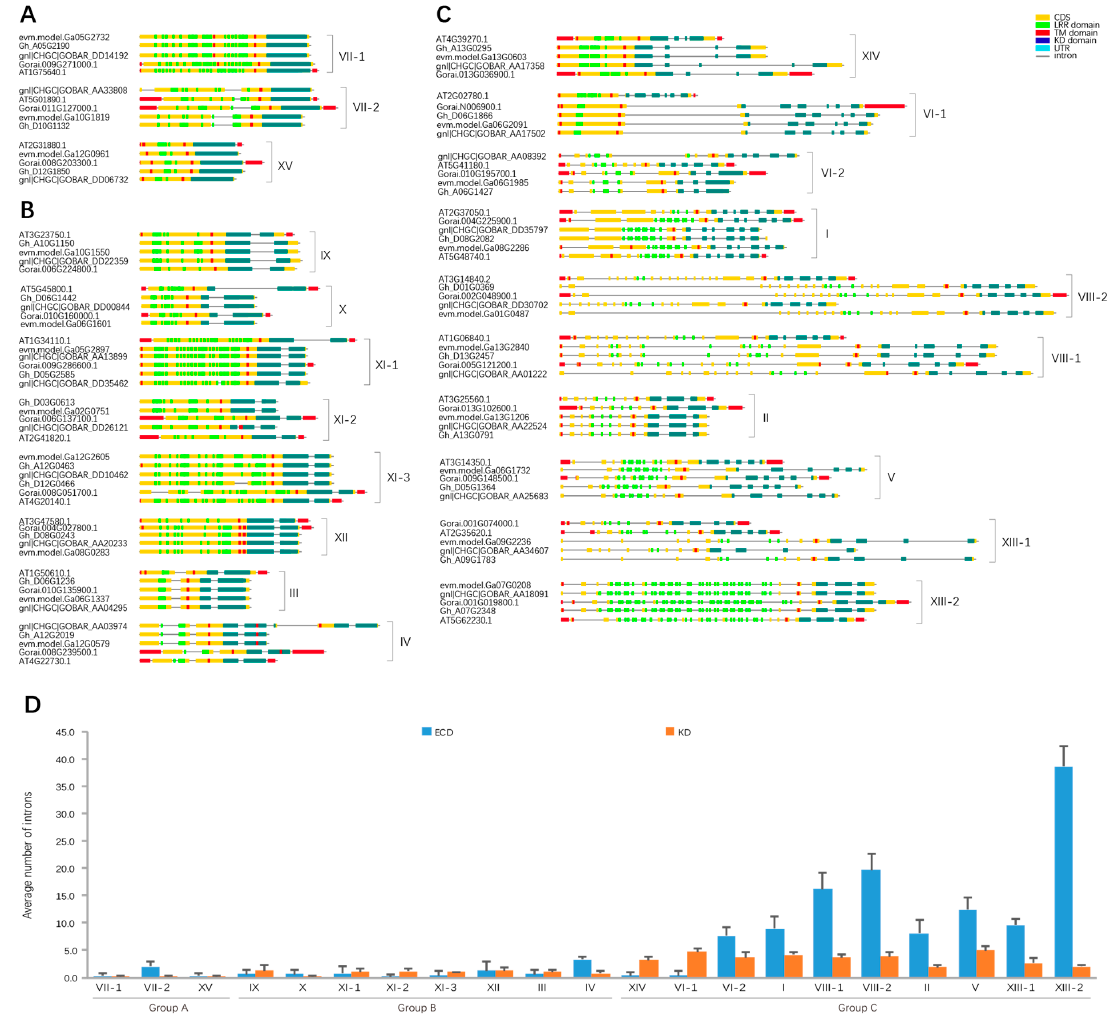
Figure 2. Exon-intron structures of representative LRR-RLK genes of each subfamily from four Gossypium species and A. thaliana . LRR (leucine-rich repeat), KD (kinase catalytic domain), and TM (transmembrane) domain coding regions were marked on exons by different colored rectangles. Based on the exon-intron structures of KD domain, Gossypium LRR-RLK genes were classified into Group A ( A ), Group B ( B ), and Group C ( C ). The number of introns in ECD (extracellular domain) and KD domain were counted and then average values were computed for each subfamily ( D ). The error bar on the column represented standard deviation of the subfamily.